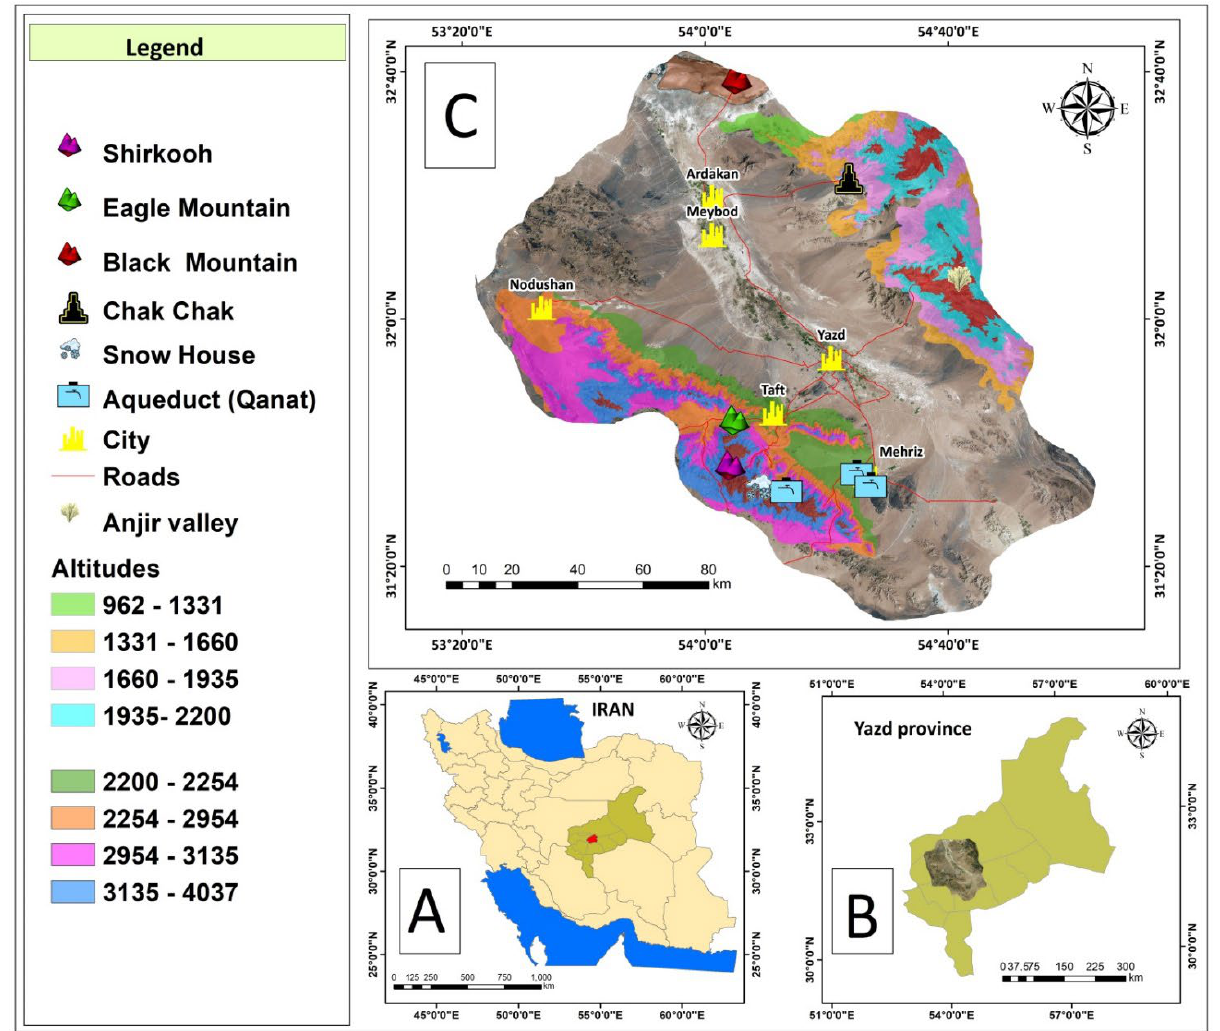
Figure 2. The geographical position of geotourism and ecotourism attractions in the Yazd–Ardakan Plain: location of Yazd Province in Iran ( A , B ); satellite image with the spatial distribution of geotourism and ecotourism attractions ( C ).